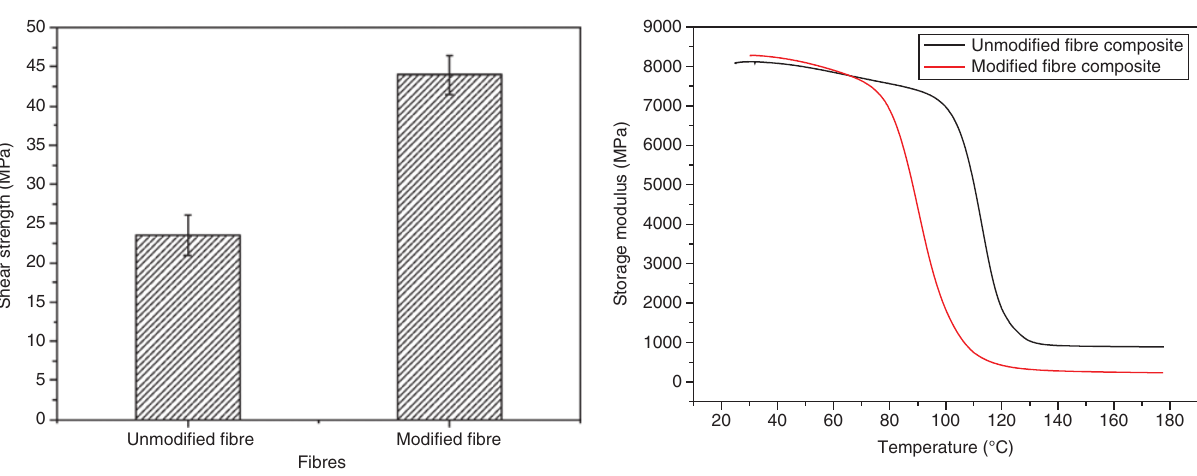
Figure 13: Storage modulus of control and CuNPs modified flax FRP